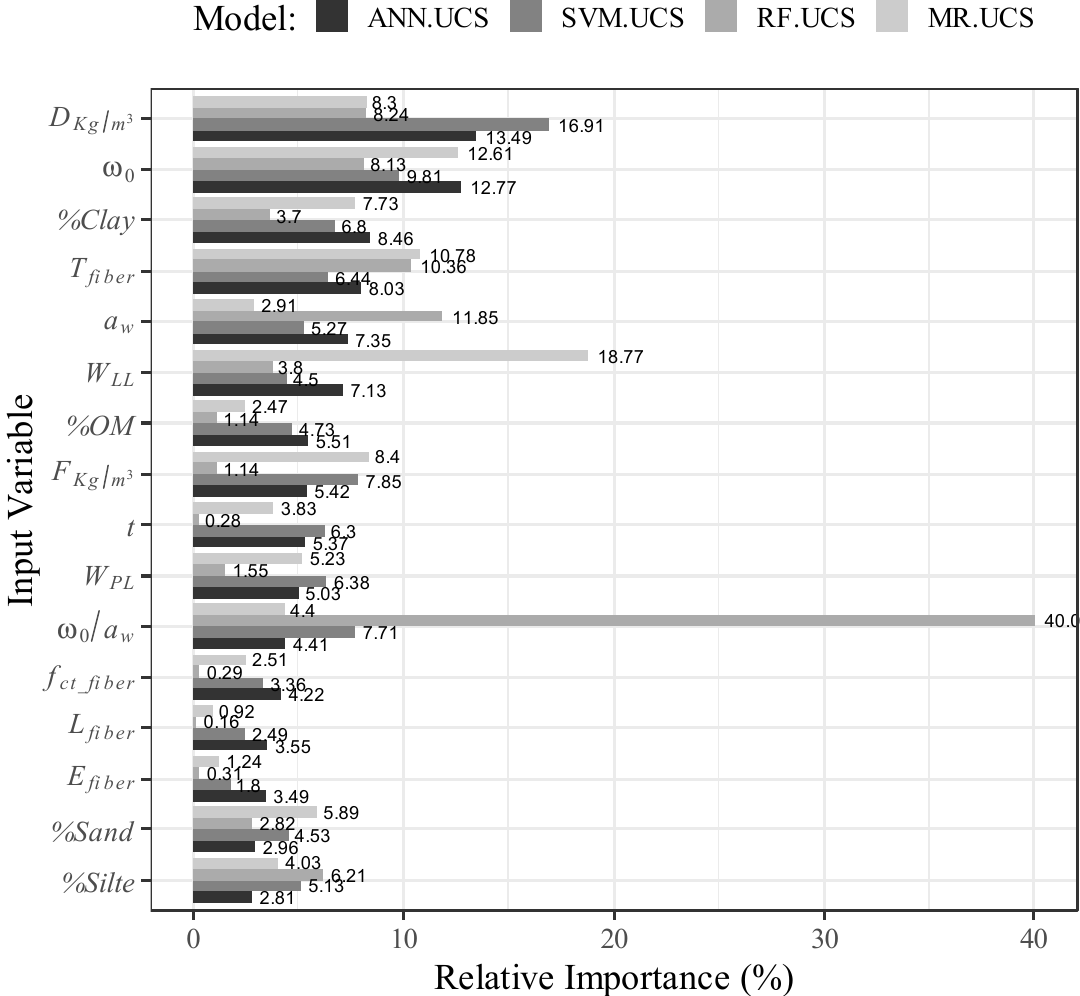
Figure 5. A comparison of the relative importance of each input variable based on a GSA in the UCS prediction of soil–binder–water mixtures reinforced with fibers.